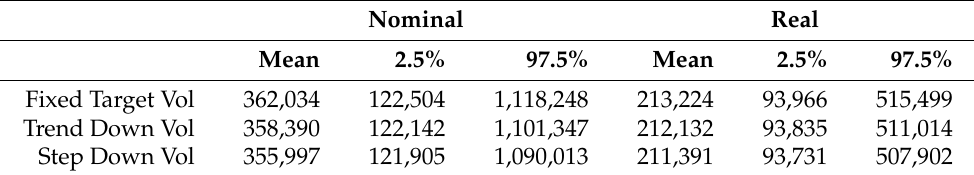
Table 15. PV Annuity Payments at Different Target Volatilities.